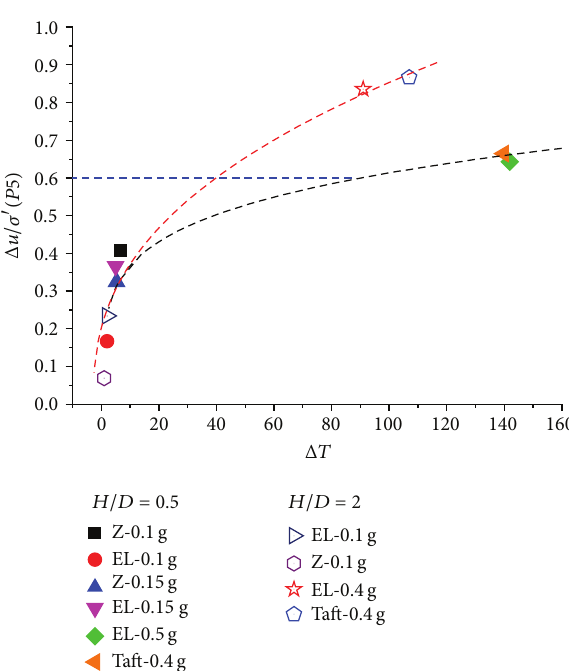
Figure 11: Relationship among increment of stabilizing force, Δ𝑢/𝜎 󸀠 and excitation.